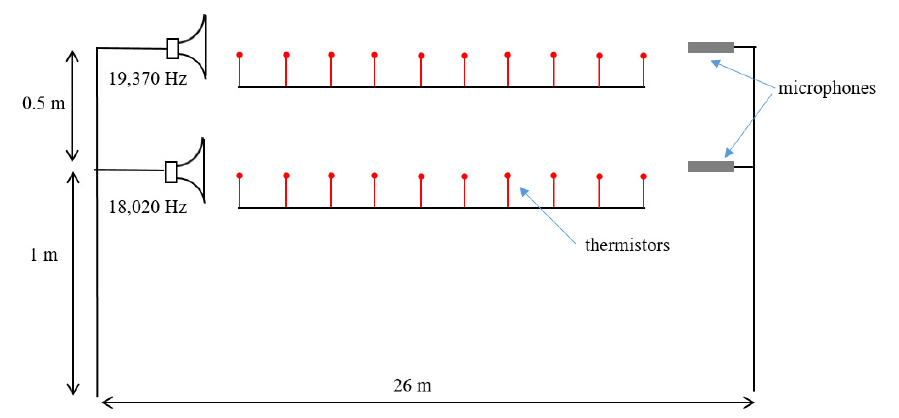
Figure 8. Sketch of the experimental setup for the measurement of the vertical temperature gradient.